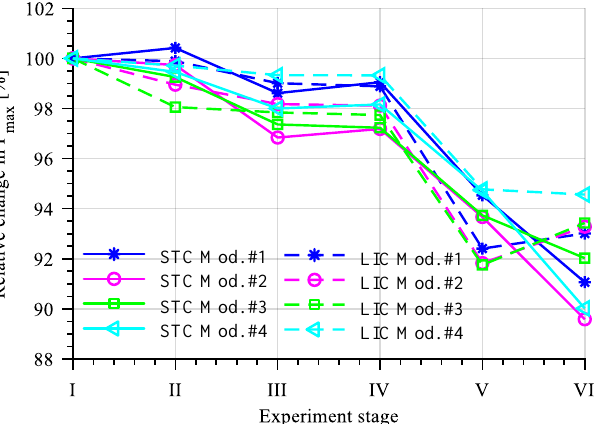
Figure 2. Relative change in the STC and low light maximum power of the fours test samples during the six stages of degradation.